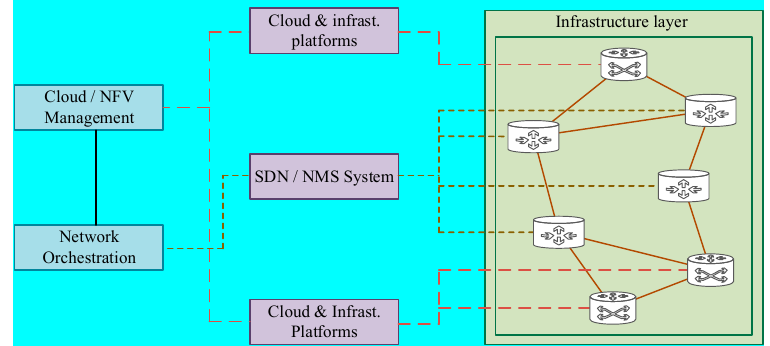
Figure 2. The architecture of QKD networks with cloud/NFV orchestration and SDN control plane [18].